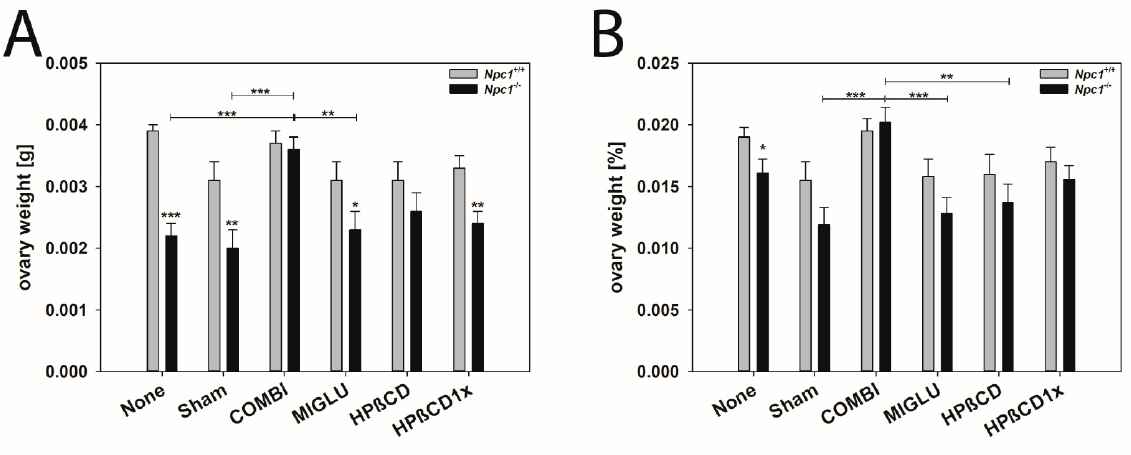
Figure 11. Ovary weight ( A ) and relative ovary weight ( B ) of Npc1 mice. Significant post-hoc tests are indicated by asterisks (* p < 0.05, ** p < 0.01, *** p < 0.001). Data are means ±